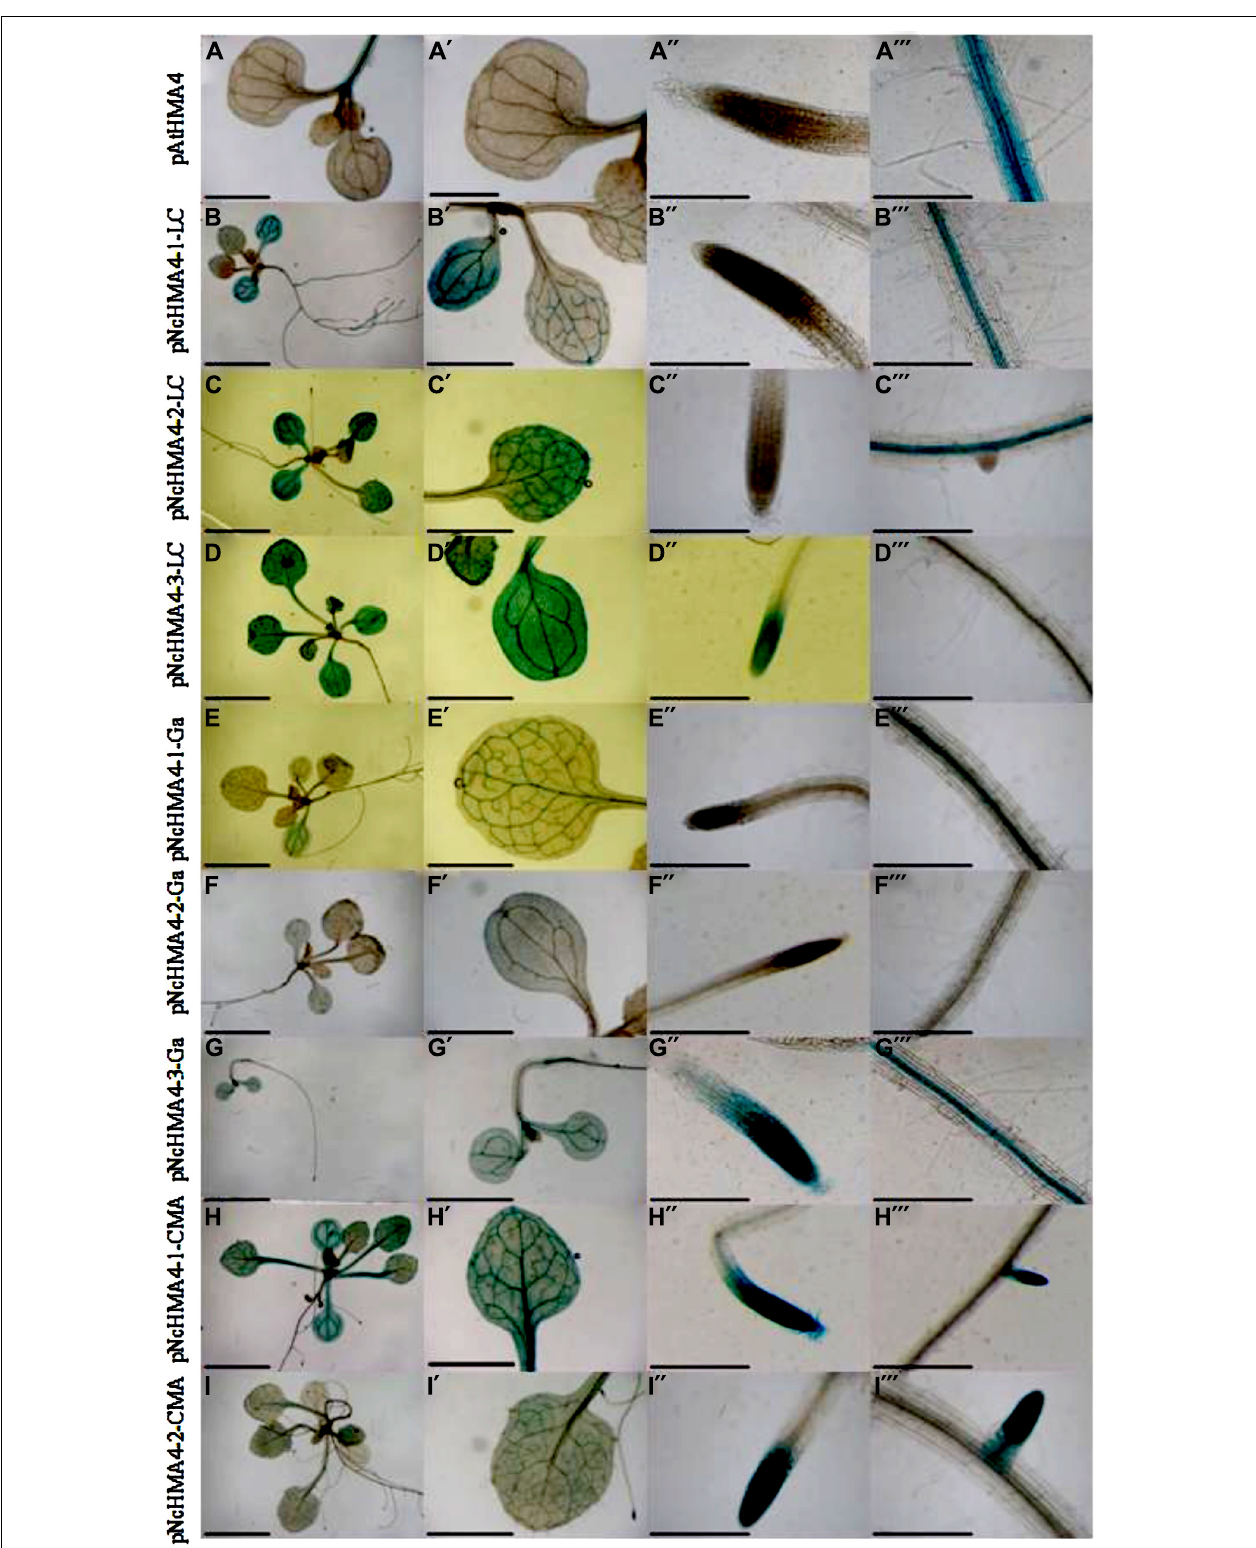
FIGURE 5 | Arabidopsis (wt) plants expressing GUS under AtHMA4 and NcHMA4 promoters from the accessions LC, Ga and CMA. [Scale bar = 5 mm in (A) to (I) , 2 mm in (A (cid:2) ) to (I (cid:2) ) and 30 μ m in (A (cid:2)(cid:2) ) to (I (cid:2)(cid:2)(cid:2) ) ].